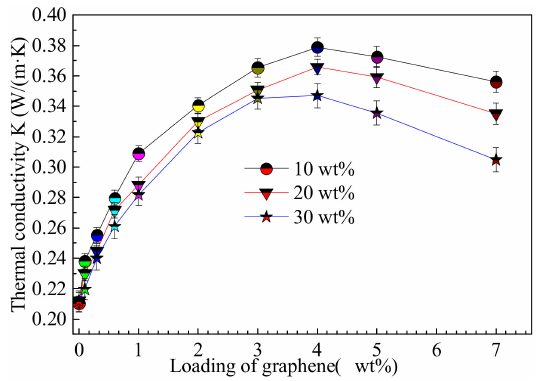
Figure 4. Thermal conductivities of G-TPU composite films prepared with different graphene loadings and initial TPU